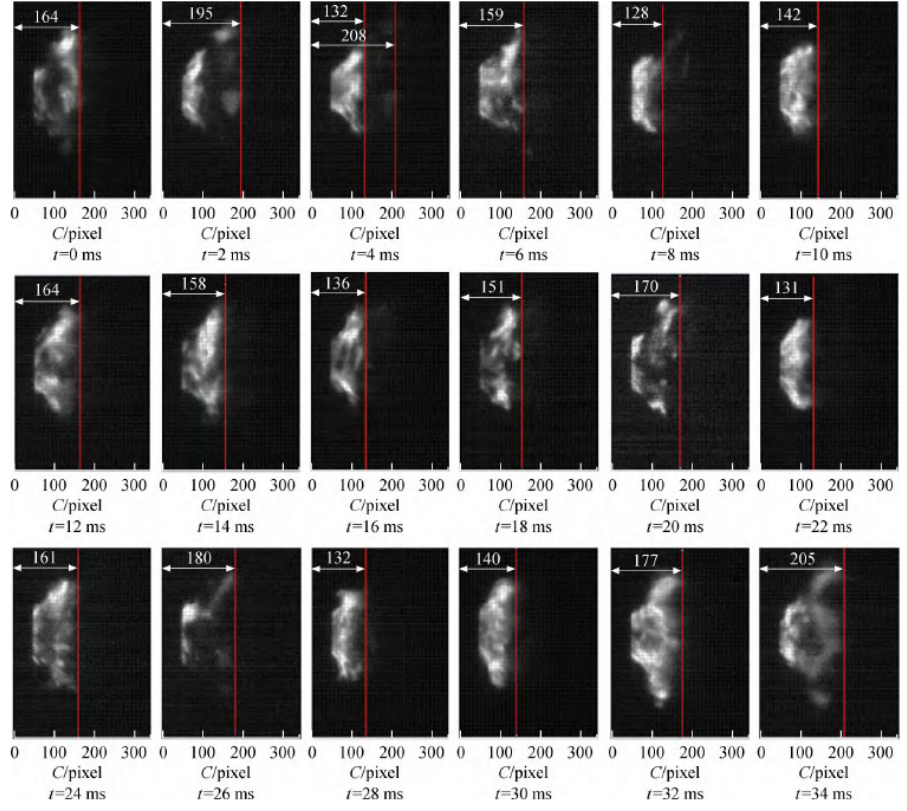
Figure 11. Flame image changes within 0–34 ms of the M combustor.